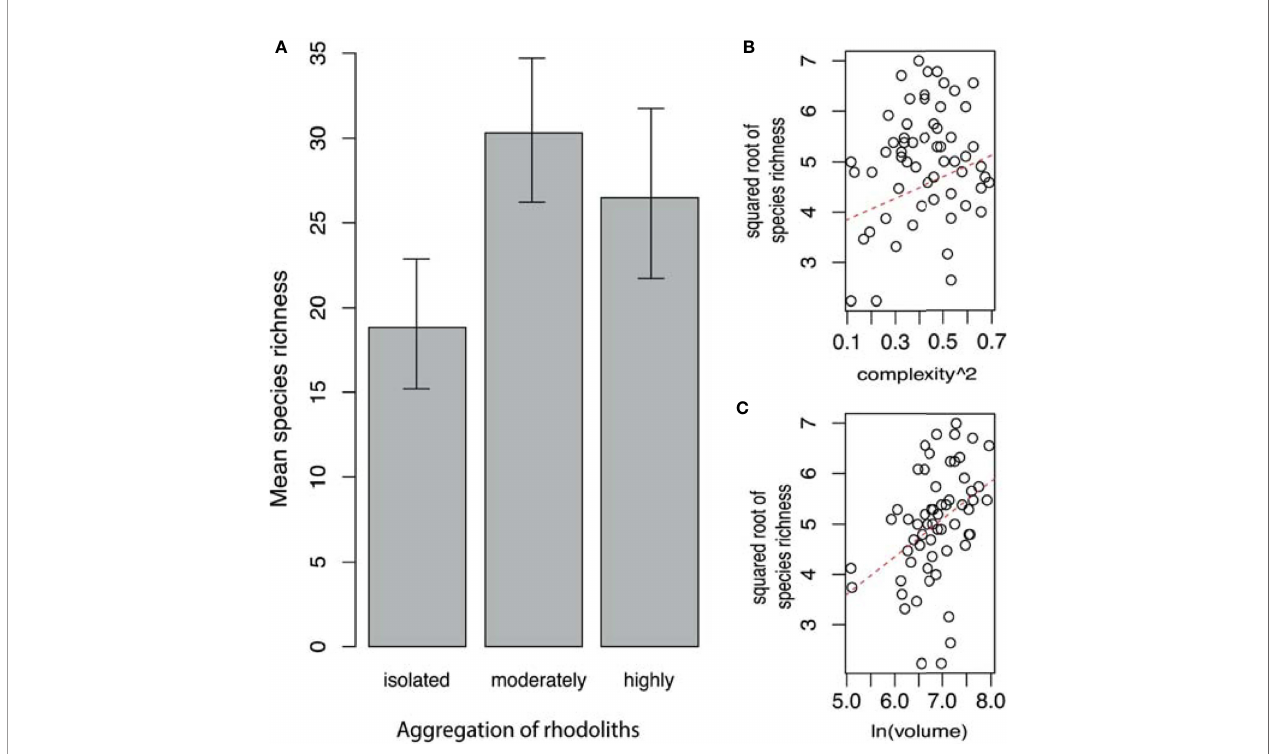
FIGURE 4 | (A) Mean of fauna species richness (with 95% con fi dence limits) by aggregation of rhodoliths. (B) Relationship between faunal species richness and complexity of rhodoliths. (C) Relationship between faunal species richness and volume of rhodoliths (Isla del Coco, Costa